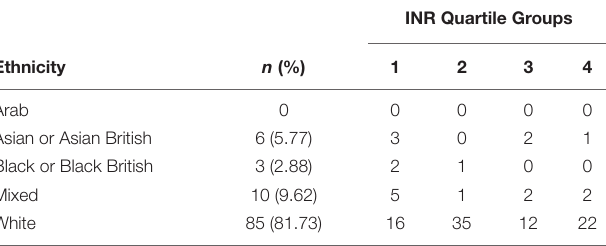
TABLE 1 | Subject ethnicity by income-to-needs